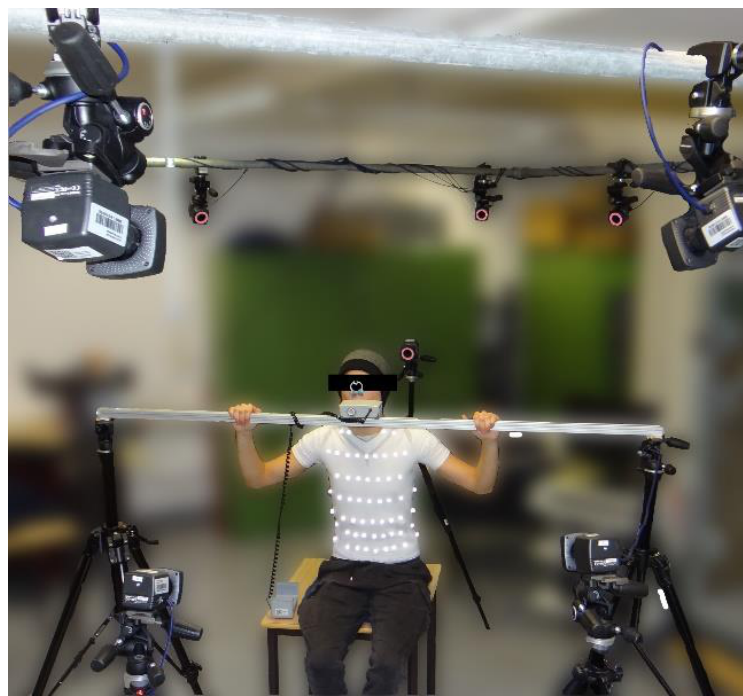
Figure 3. Measurement setup: A subject wearing the compression shirt with MoCap markers, breathing through the spirometer which was fixed on the rigid mount and surrounded by the MoCap cameras.